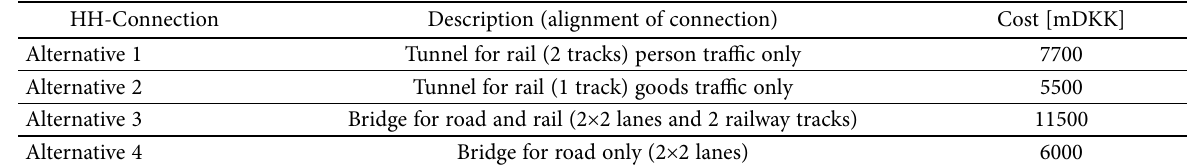
Table 1. The proposed four alternatives for the HH-Connection with construction costs in million DKK (adapted from Larsen, Skougaard 2010) HH-Connection